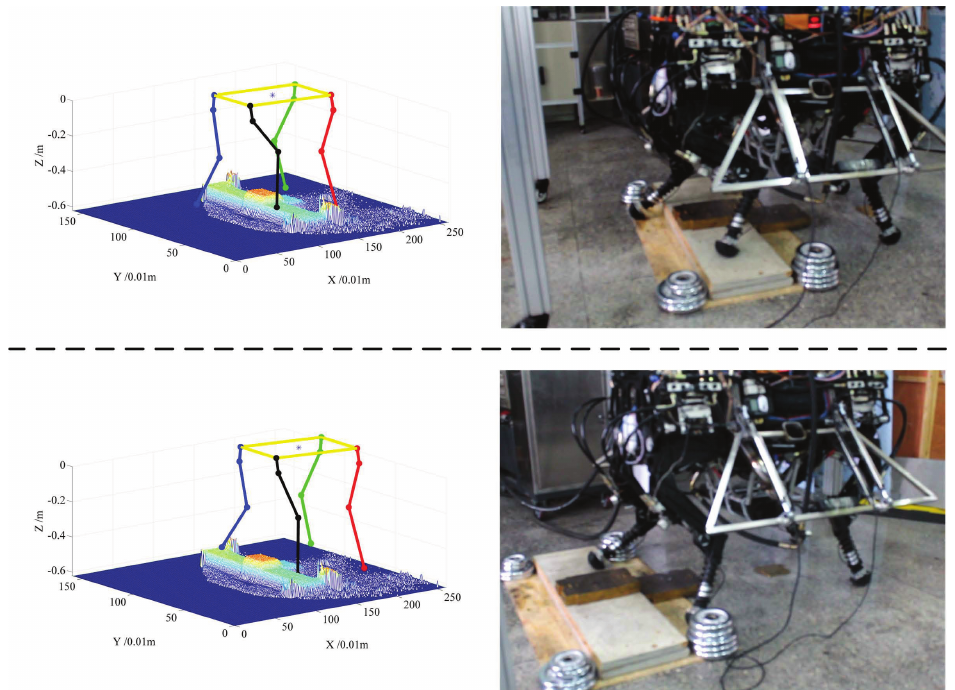
Figure 13. Screenshots of walking across the step, and corresponding poses of the robot on the elevation map, the upper panel shows a case of lifting and placing the right rear foot on the step, and the lower panel shows cases of putting the foot onto the ground.